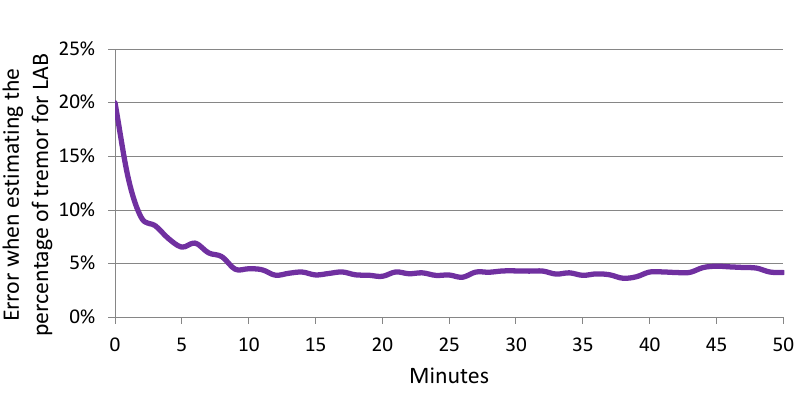
Figure 14. Error when estimating the percentage of tremor depending on the duration (minutes) considered to estimate the